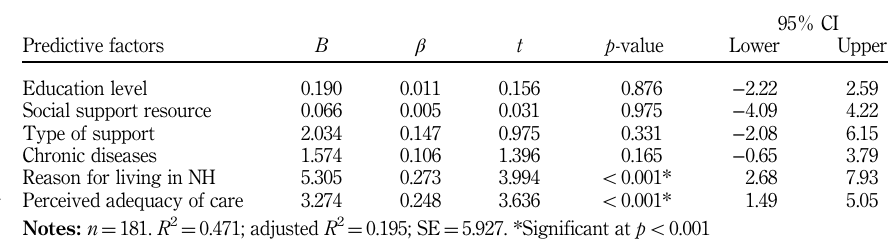
Table III. Multivariate linear regression analysis of QoL